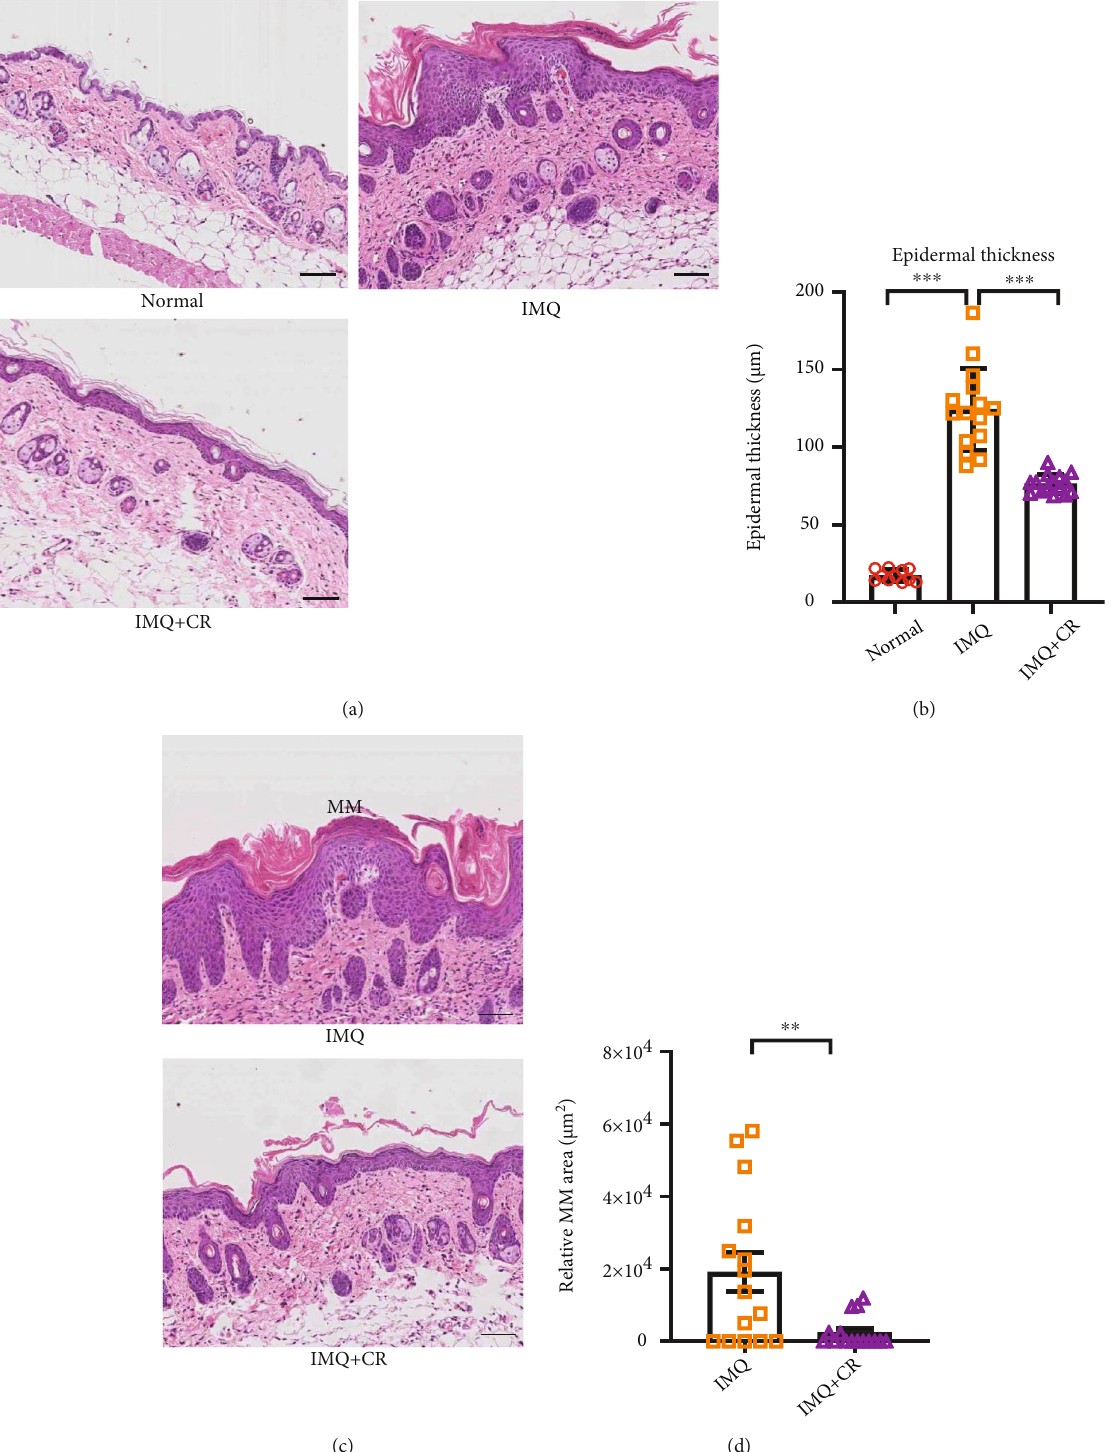
Figure 2: CR treatment reduced the epidermal thickness and diminished neutrophil accumulation in IMQ-induced PsD in mice. (a) Representative microscopic images of H&E-stained skin sections from each group (scale bar = 145 μ m ). (b) Epidermal thickness was evaluated using Leica Microsystems software under a microscope. n = 11 in the normal group; n = 15 in IMQ group and IMQ+CR group. (c) Representative image of MM ( scale bar = 145 μ m ). (d) Quanti fi cation of MM area. n = 15 in both the IMQ and IMQ+CR group. Epidermal thicknesses were compared by using one-way ANOVA and post hoc Tukey ’ s test, and MM areas were compared using a t -test. Data are shown as the Mean ± SEM . ∗∗ P < 0 : 01and ∗∗∗ P < 0 : 001